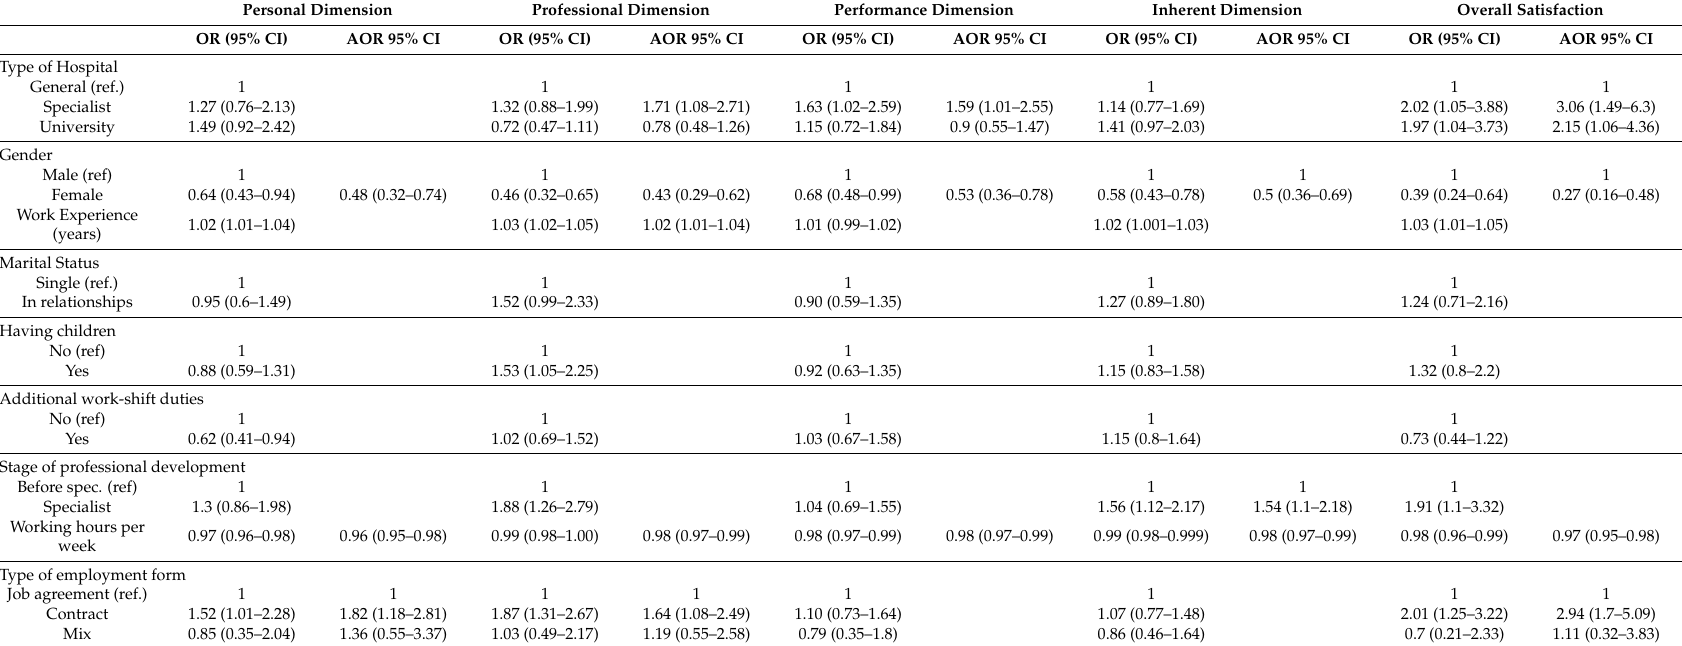
Table 3. Factors associated with higher levels of career satisfaction of physicians in Polish hospitals, overall and by the four dimensions ( n = 1003). Personal Dimension Professional Dimension Performance Dimension Inherent Dimension Overall Satisfaction OR (95% CI) OR (95% CI) AOR 95%